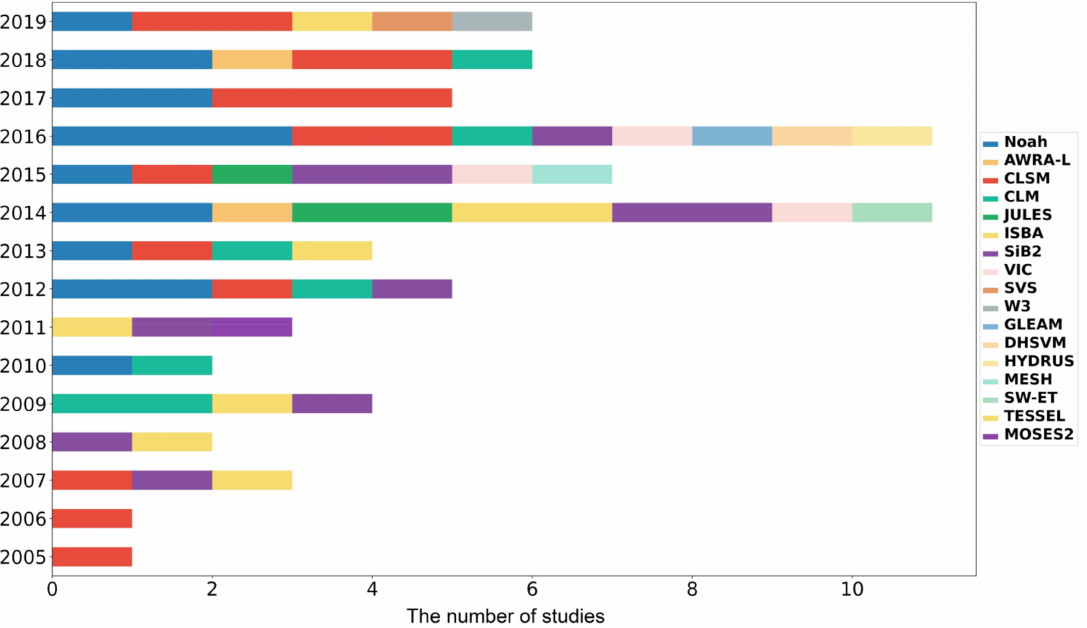
Figure 3. SM assimilation studies classified by LSMs between 2005 and 2019 (legend acronym explanation in Table